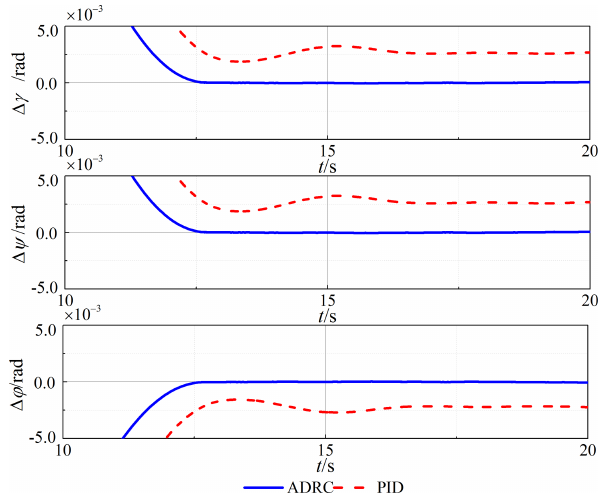
Figure 8. Attitude error in the steady-state process.